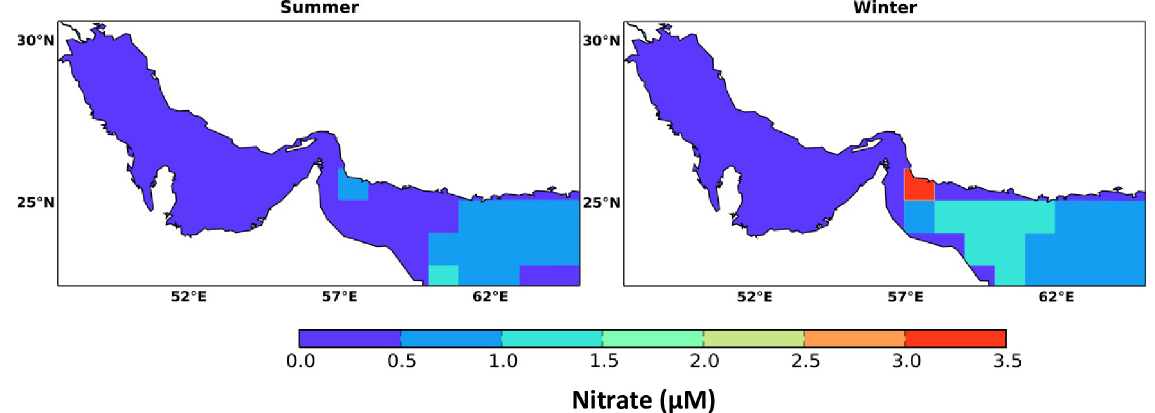
Fig 2. Seasonal spatial distribution of ocean surface nitrate in the Arabian Gulf and Sea of Oman calculated from the monthly climatology of the World Ocean Atlas data (WOA) for the year 2018. The WOA data are climatological data collected from the periods 1900–2017.